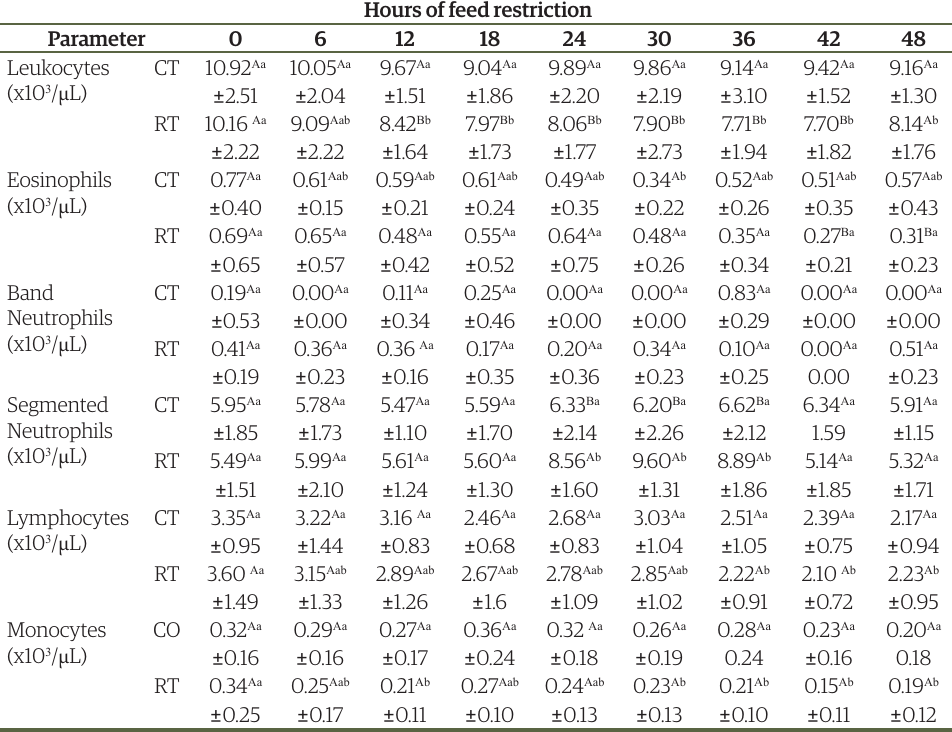
SD of levels of serum triglycerides (TG), total cholesterol (BT), glucose, blood urea nitrogen Table 4. Mean (BUN) and creatinine in horses during feed restriction (RT) for 48 h and in control horses (CT). ±